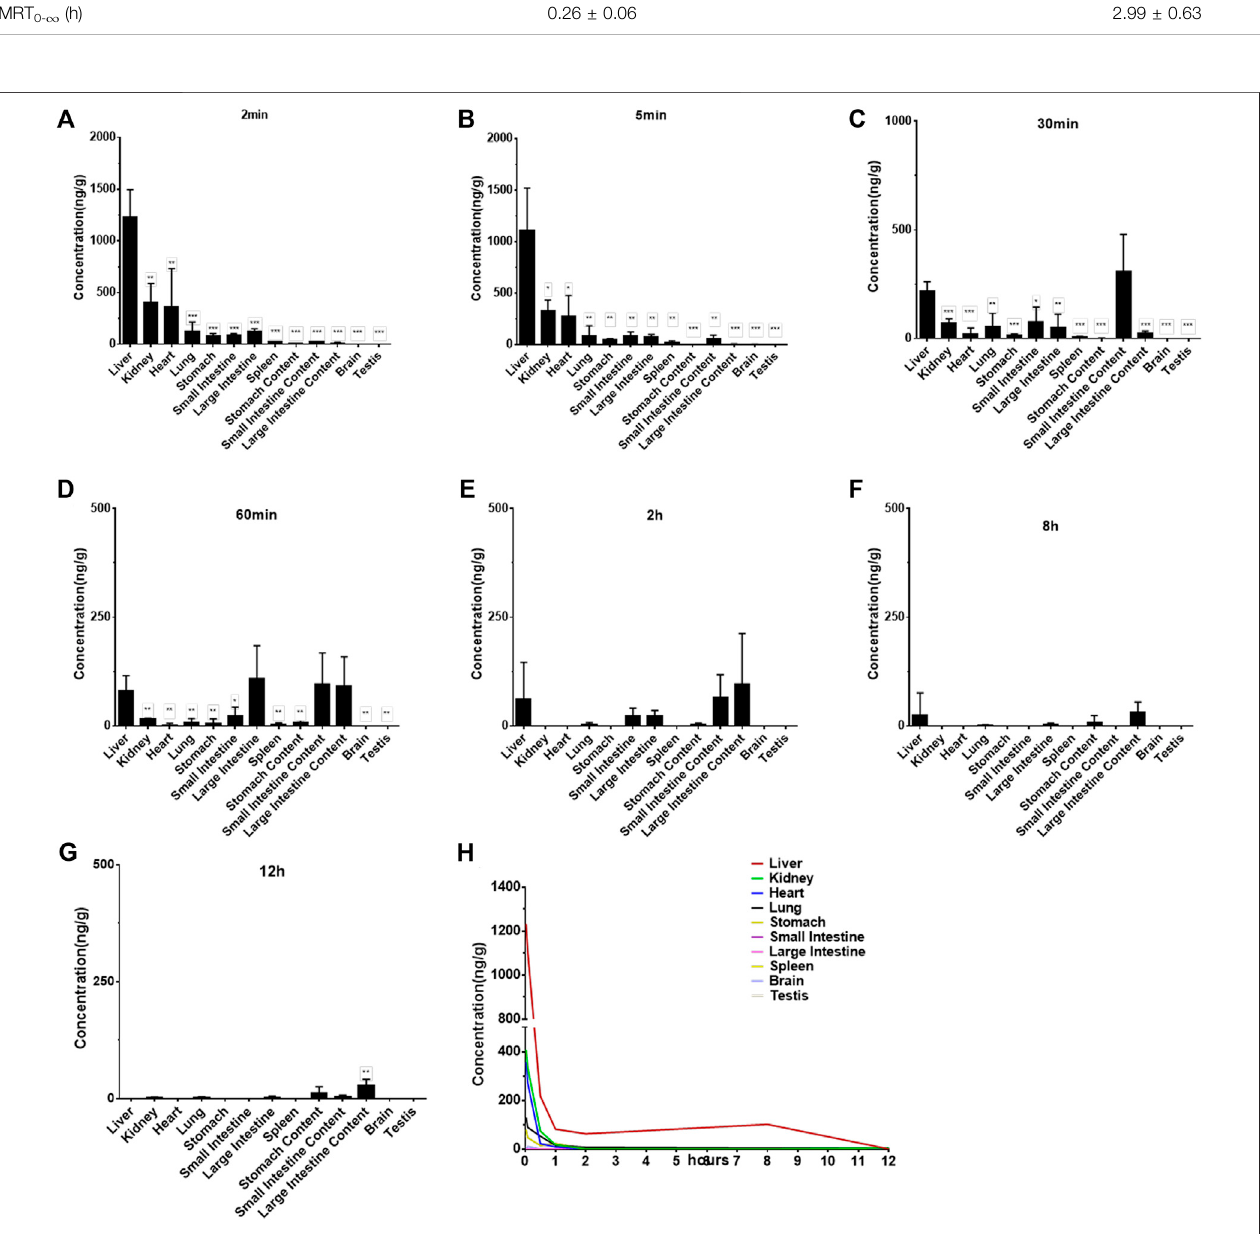
FIGURE 4 | Indo5 concentration in different tissues following intravenous administration (1 mg/kg) ( n (cid:2) 4) at the indicated time points in rats (A – G) . Data are presented as the mean ± SD. Two-tailed t tests were performed. * p < 0.05, ** p < 0.01, *** p < 0.001 when compared to Indo5 concentration in the liver. (H) concentration – time pro fi les of Indo5 in the indicated